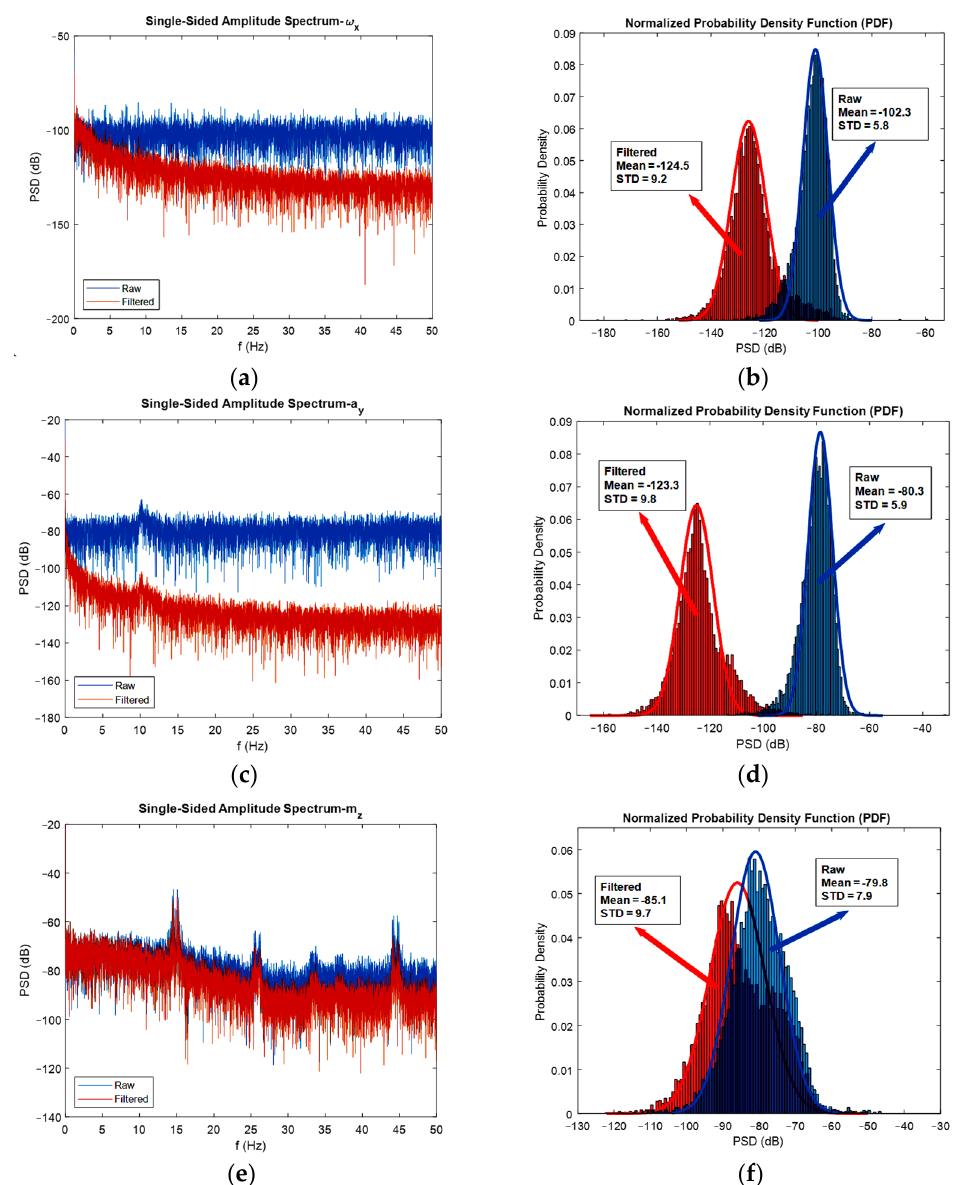
Figure 11. FFT diagrams ( a , c , e ), and histograms for the stationary gyroscope, accelerometer, and magnetometer ( b , d , f ), respectively.